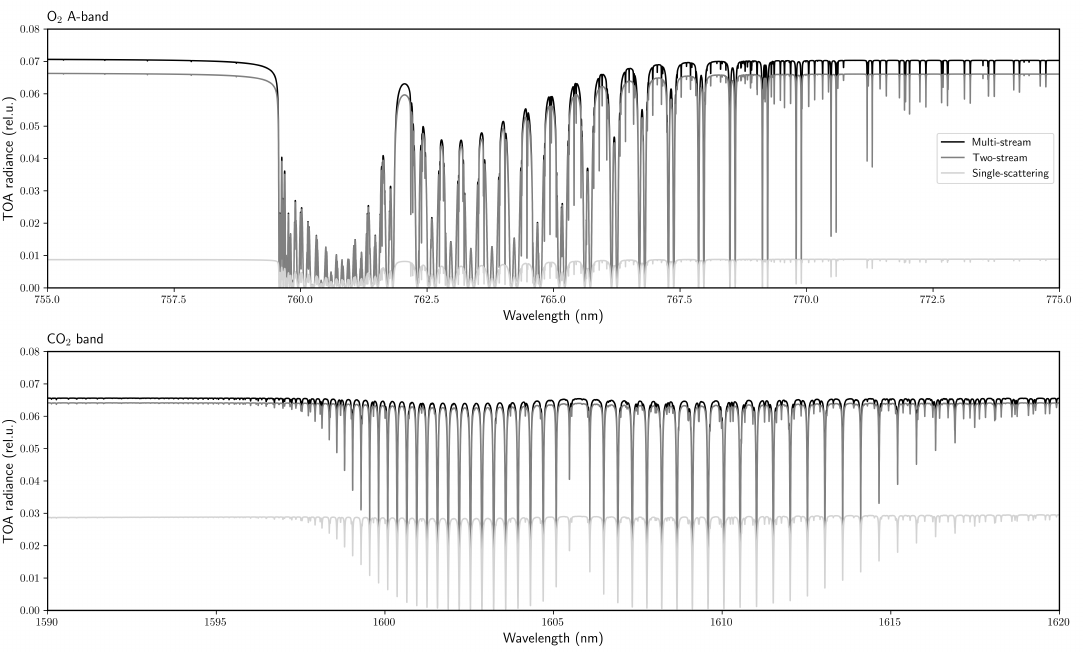
Figure 2. Spectral radiances for the ‘Aerosol 2’ scenario computed by using the multi-stream (black), the two-stream (gray) and the single-scattering (light gray) RTMs: (upper panel) O 2 A-band, (lower panel) CO 2